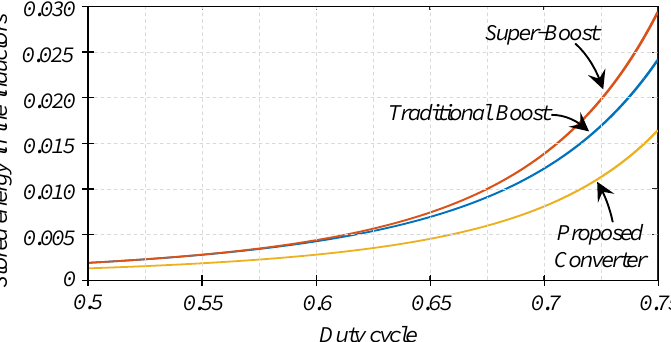
Figure 9. The stored energy in inductors is compared between the traditional boost, the super boost, and the proposed ISB converter.